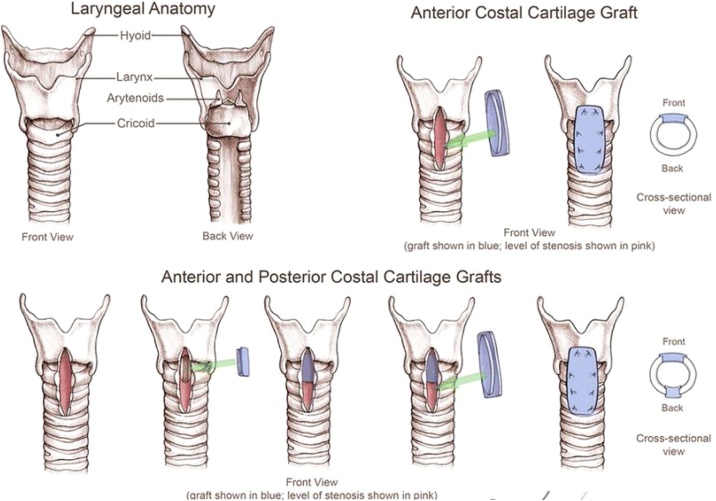
Laryngeal Anatomy, Anterior Costal Cartilage Graft and Anterior and Posterior Costal Cartilage Grafts.Image: Prickett K.K., Jacobs I.N. (2015) Neonatal Subglottic Stenosis. In: Lioy J., Sobol S. (eds) Disorders of the Neonatal Airway. Springer, New York, NY.